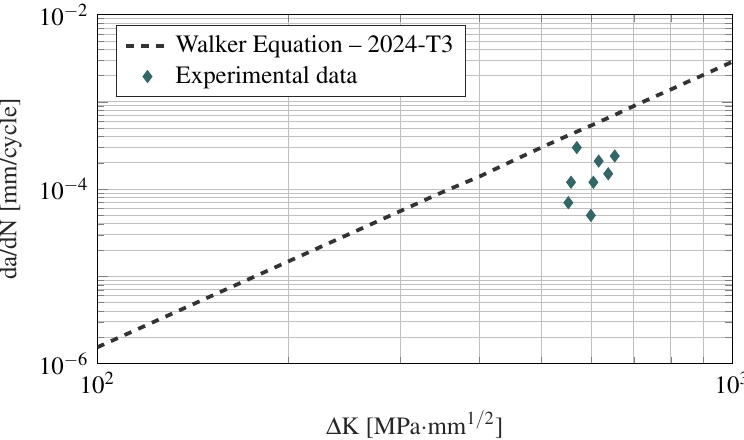
Figure 10. Crack growth data for QQ-A-250/5 ‘O’ M(T) aluminum specimen correlated with the stress intensity